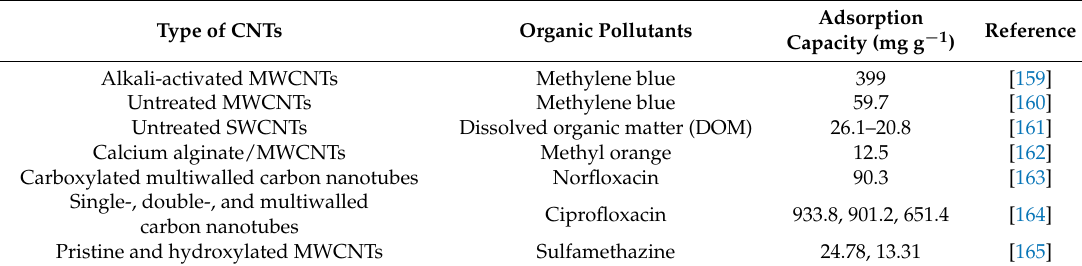
Figure 13. UV ‐ vis spectra showing methyl orange degradation using MWCNTs/Pd nanostructured Figure 13. UV-vis spectra showing methyl orange degradation using MWCNTs/Pd nanostructured material. Reproduced with permission from [158]. Copyright Elsevier, 2016. material. Reproduced with permission from [158]. Copyright Elsevier, 2016. Table 3. Removal of organic toxins via different types of Table 3. Removal of organic toxins via different types of CNTs.